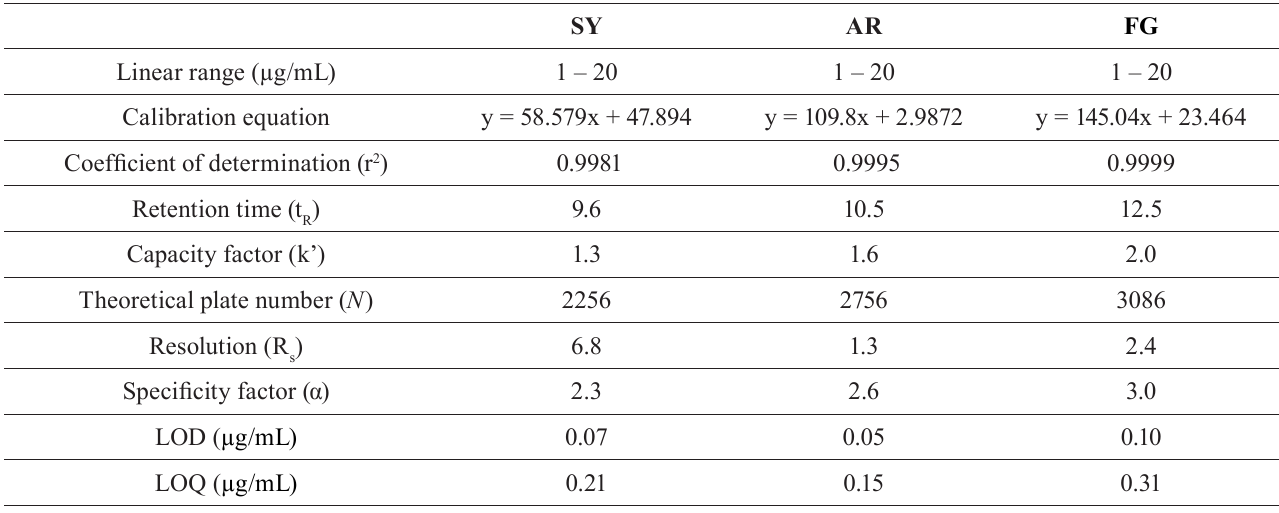
TABLE III - Chromatographic characteristics and system suitability